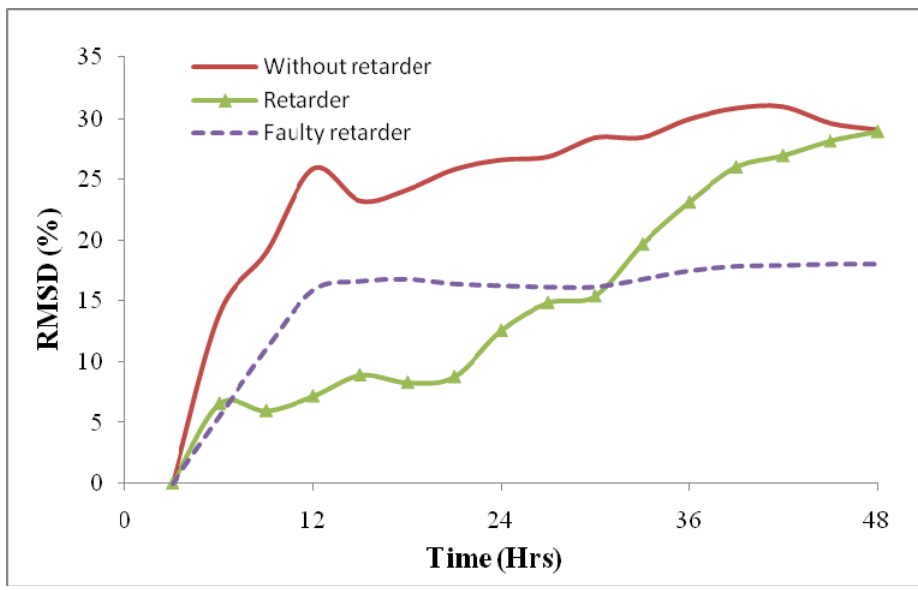
Figure 13. Effect of retarder and faulty retarder on hydration